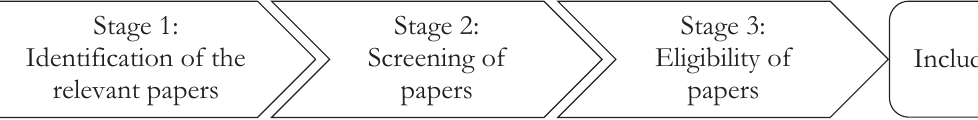
Figure 1. Overall research methodology